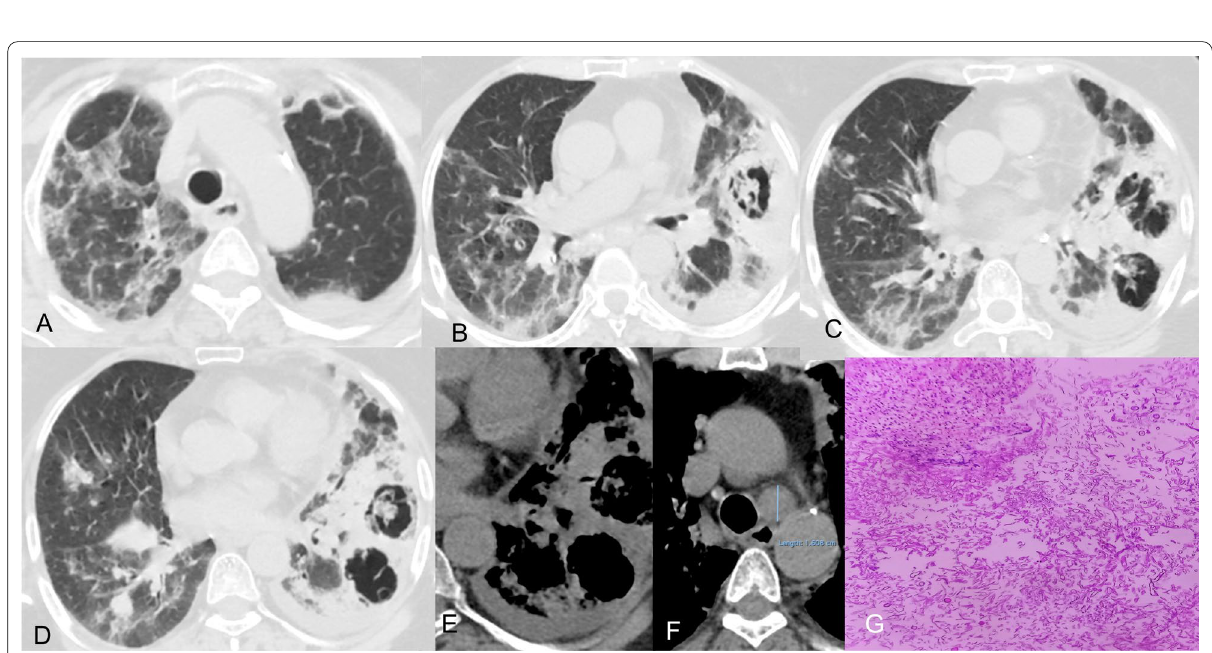
Fig. 7 HRCT chest lung window. ( A – D ) Two large thick walled cavities are seen in left lower lobe with internal soft tissue density contents giving bird’s nest appearance on the background of changes of COVID-19 pneumonia. E , F Mediastinal window images showing soft tissue density contents within cavity and left pleural effusion along with an enlarged aorto-pulmonary node ( F ). G Microphotograph from lung biopsy specimen showing magenta coloured septate fungal hyphae in the necrotic material likely to be mucormycosis (H&E stain